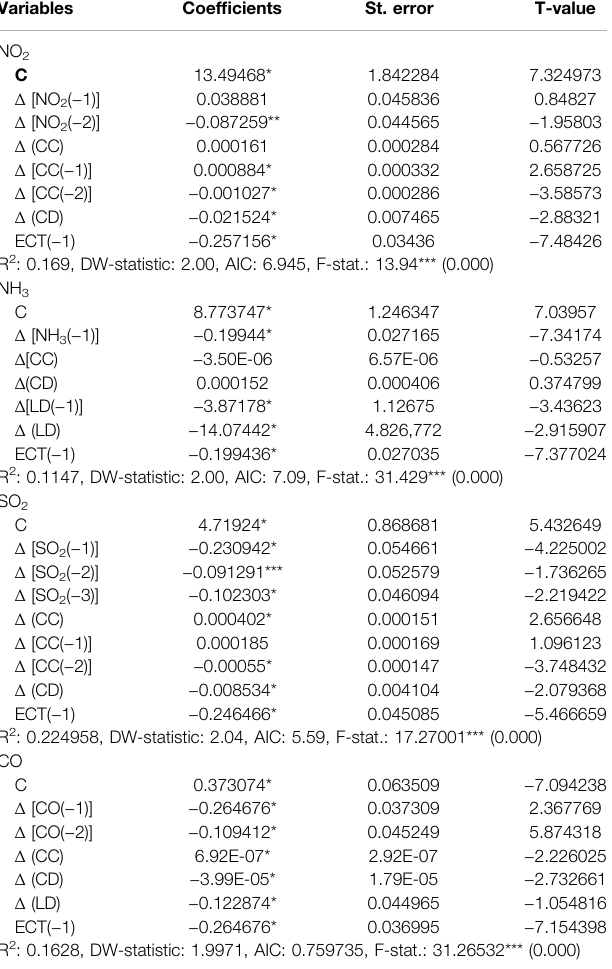
TABLE 4 | The estimated short-run coef fi cients based on Akaike information criterion (AIC). Variables